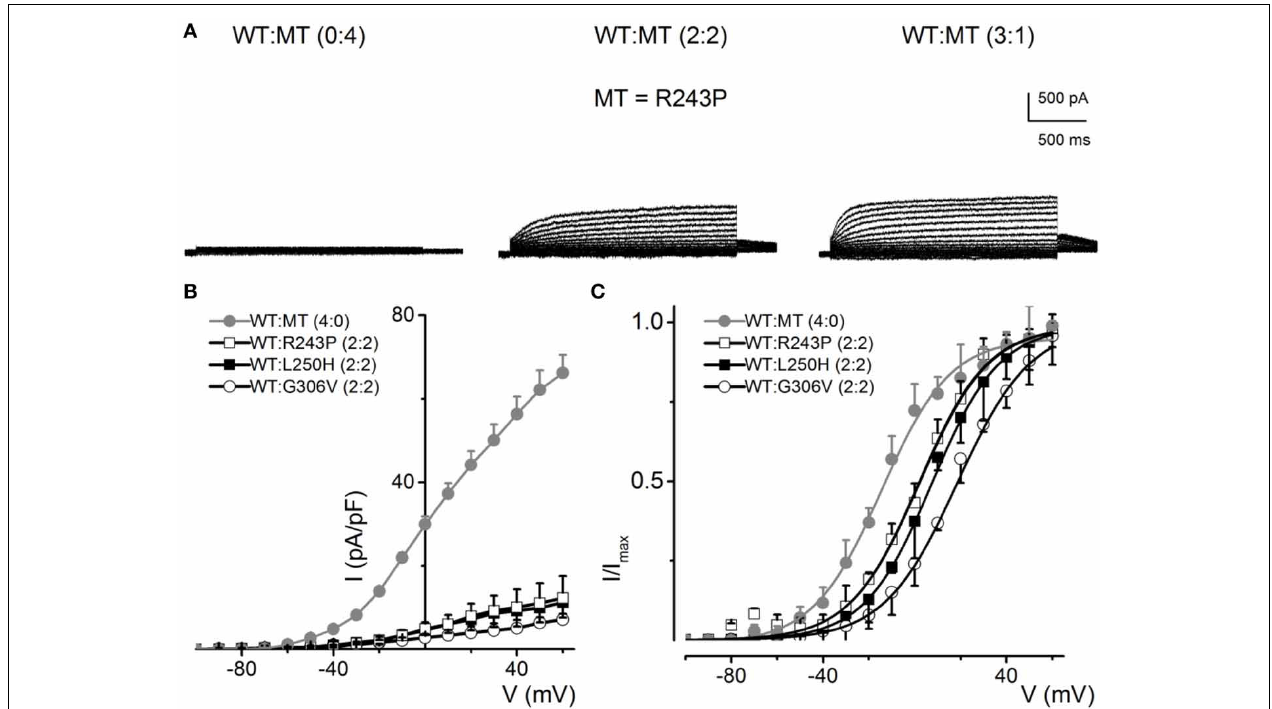
andacombination(ratio2:2)ofWTKv7.1andMTs(MT-R243P (cid:7) ,MT-L250H (cid:3) , and MT-G306V (cid:4) ). (C) Co-expression of WT hKv7.1 and MT-R243P, L250H and G306V at a ratio (2:2) produced a right-ward shift in the voltage-dependent activation of the resulting currents. Steady-state activation curves of hKv7.1 alone ( ) and after suppression by co-expression with the MT channels are shown.Tailcurrentsweremeasuredat − 40mV,andnormalizedtothelargesttail current magnitude, and plotted against the preceding pre-pulse voltages. The midpoint (V 1 / 2 ,inmV) andtheslopefactors(k,inmV)wereasfollows: V 1 / 2 and k for WT-hKv7.1 alone and in combination WT-hKv7.1:R243P, WT-hKv7.1:L250H, andWT-hKv7.1:G306Vwere − 15 . 8 ± 1 . 2,11.8 ± 0.9;2.5 ± 1.1,12.4 ± 0.6;7.6 ± 2.2, 12.7 ± 1.0; 15.7 ± 2.4, 12.8 ± 1.6mV ( n = 11),